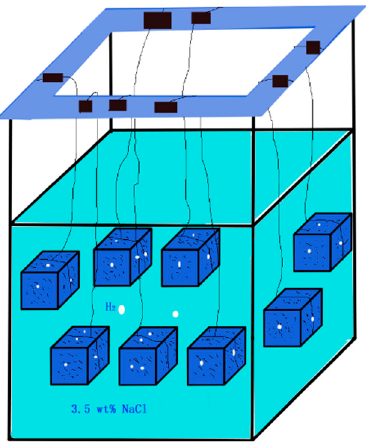
Figure 2. Schematic diagram and actual picture of the weight loss experiment.